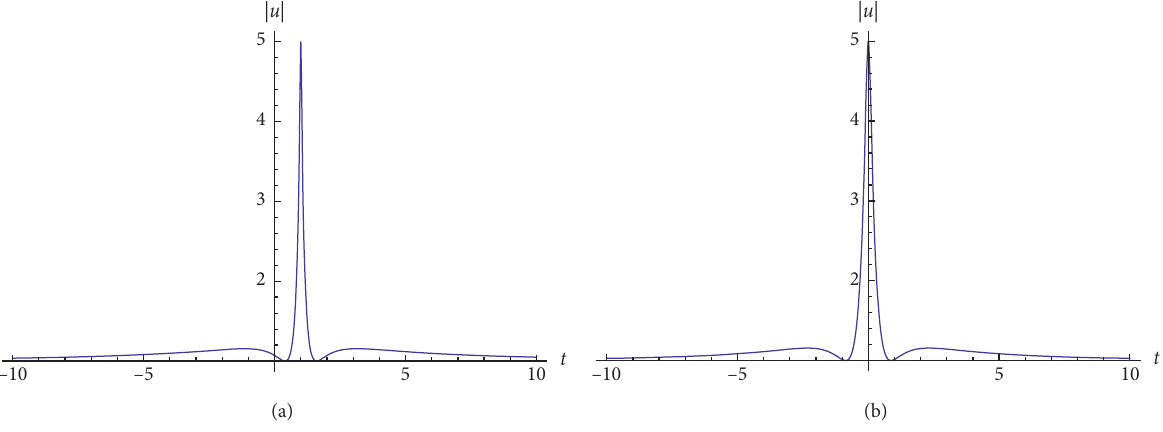
Figure 9: Dynamic evolution of first-order fractional rogue wave solution (39) and its comparison with the integer order. (a) α � 9/7, a � 1, and x � 1; (b) α � 1, a � 0, and x � 0.